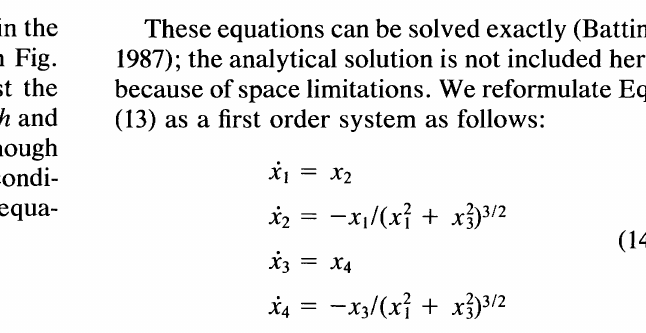
FIGURE 8 Error (at t = 10) vs. step size for the original problem.